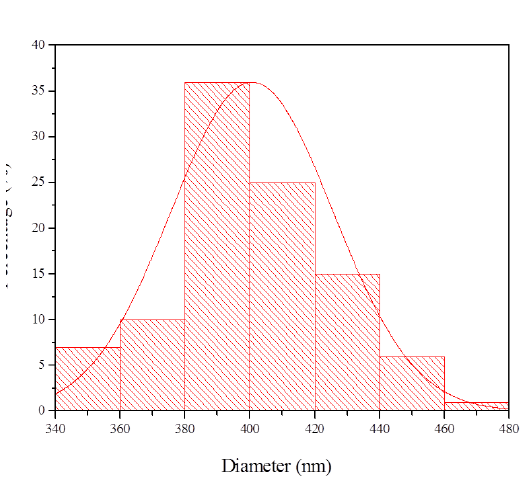
Fig. 3 Histogram of diameter distribution of PANI/Fe composite nanofibers